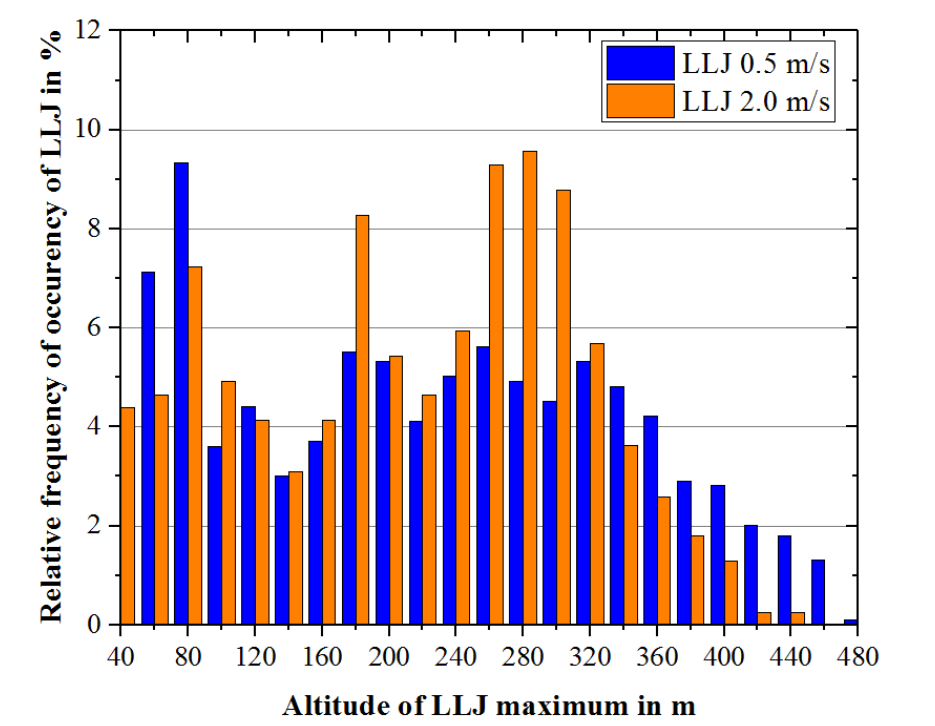
Figure 2. Comparison of LLJ events according to the criteria of 2ms − 1 (orange) and 0.5ms − 1 (blue) for the months June, July and August